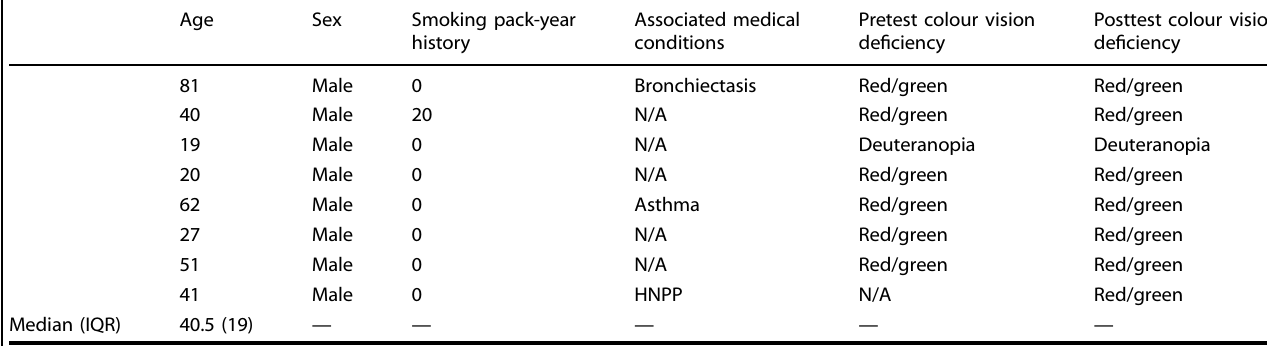
Table 4. Characteristics of the participants with known colour vision de fi ciency (CVD).